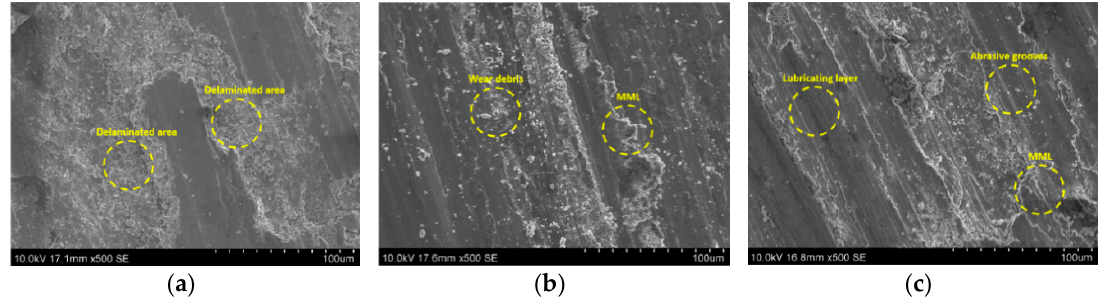
Figure 11. SEM photomicrographs of the worn surface of the sample ( a ) A390-GDC; ( b ) HAMC-4-1-1; and ( c ) HAMC-1-1-1.